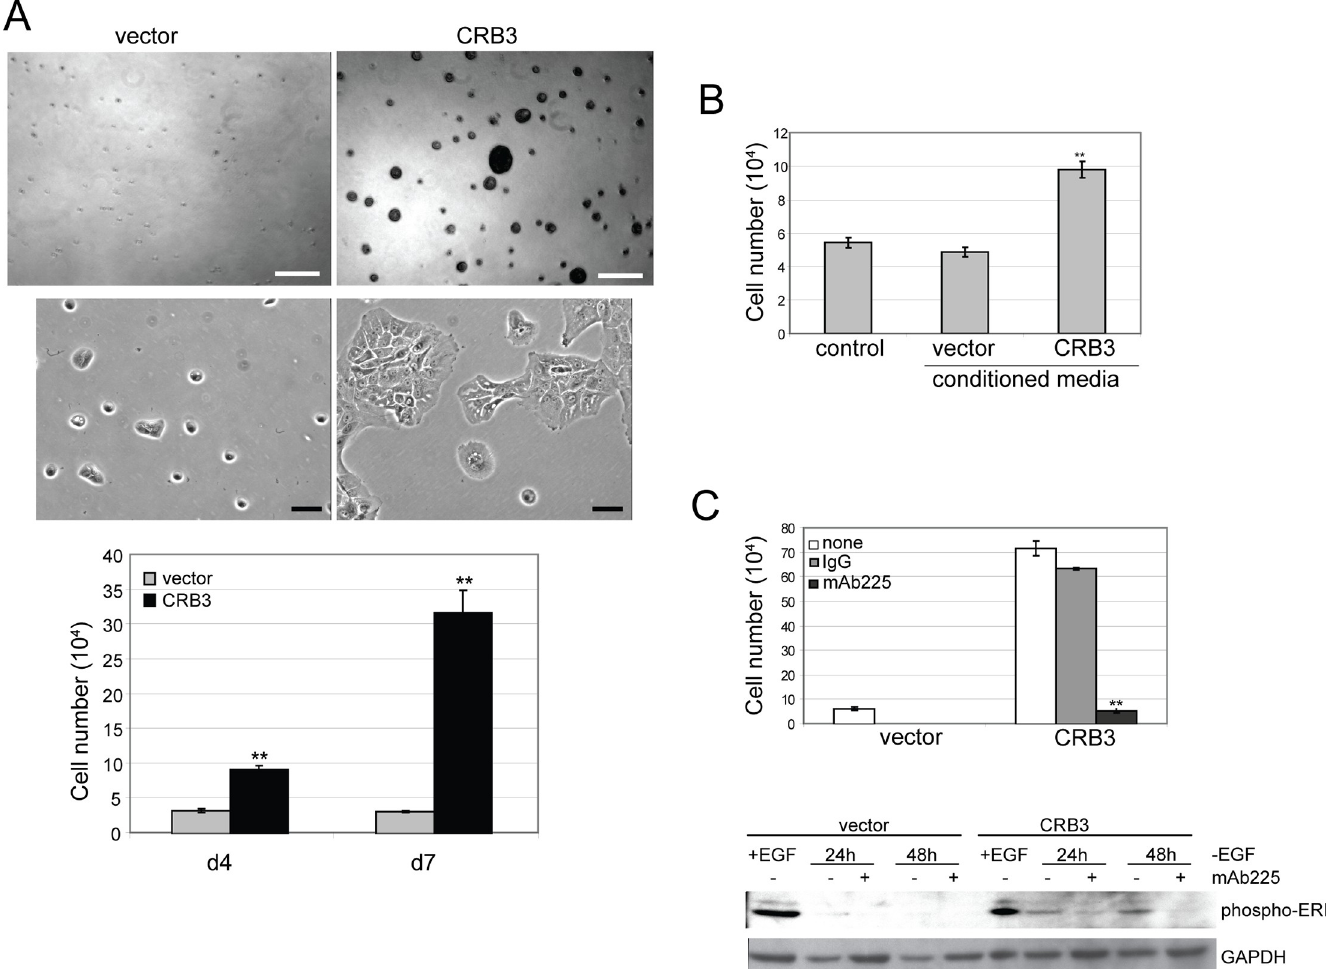
Fig 2. CRB3 expression leads to EGF-independent proliferation through a secreted factor. (A) Vector control or CRB3-expressing MCF-10A cells were cultured on Matrigel for 15 days (top) or in monolayer for seven days (middle) without EGF, and representative phase images of each are shown. Scale bars, 150 μ m (3D), 50 μ M (monolayer). EGF-independent proliferation in monolayer culture was quantified by cell counting (bottom). The results represent the mean +/-SEM from three independent experiments (n = 9) ( �� p < 0.01 by Students t test). (B) Conditioned media was collected from vector control or CRB3-expressing cells following 5 days in culture without EGF. Proliferation of normal MCF-10A cells cultured in the conditioned media was quantified by cell counting on days 5–7 after addition of each conditioned medium. Results shown are average +/-SEM of four independent experiments with each condition in duplicate ( �� p < 0.01 for CRB3 compared to vector using Students t test). (C) EGF-independent proliferation of CRB3 expressing cells is blocked by the addition of mAb225. Results are the average +/- SEM of three independent experiments with each condition in duplicate (n = 6) ( �� p < 0.01 for mAb225 compared to IgG using Students t test) (top). CRB3 expressing cells were starved of EGF for the times indicated in the presence or absence of the EGFR blocking antibody, mAb225, lysed, and analyzed for phospho-ERK by SDS-PAGE and immunoblotting. Immunoblotting for GAPDH was used as a loading control (bottom).